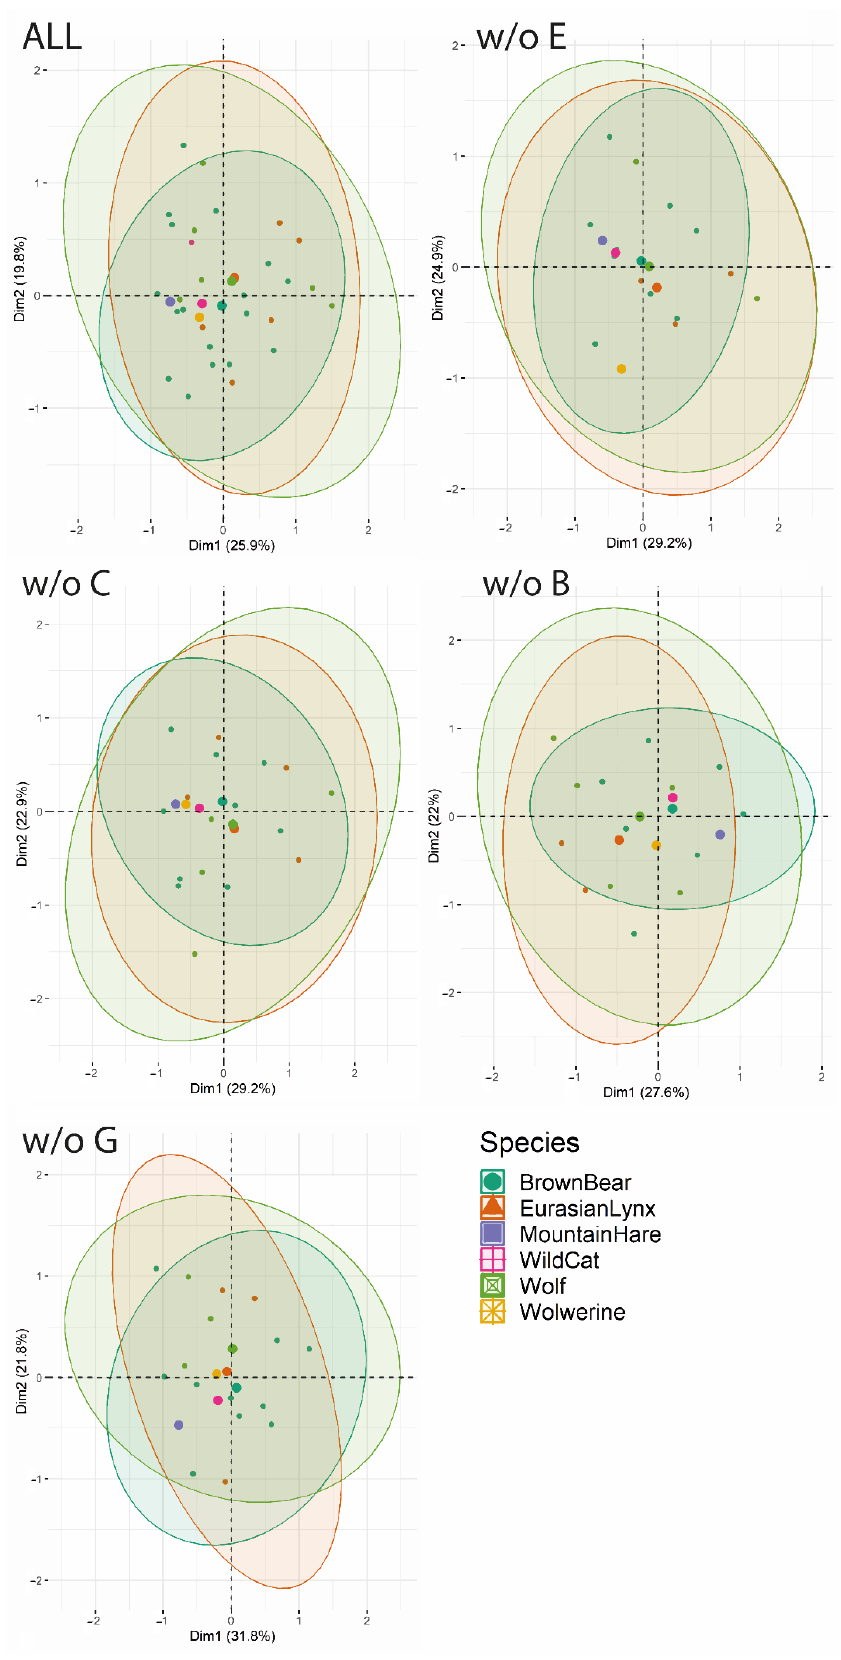
Figure A5. Graphic representation of individuals classed by species for all five MCAs.